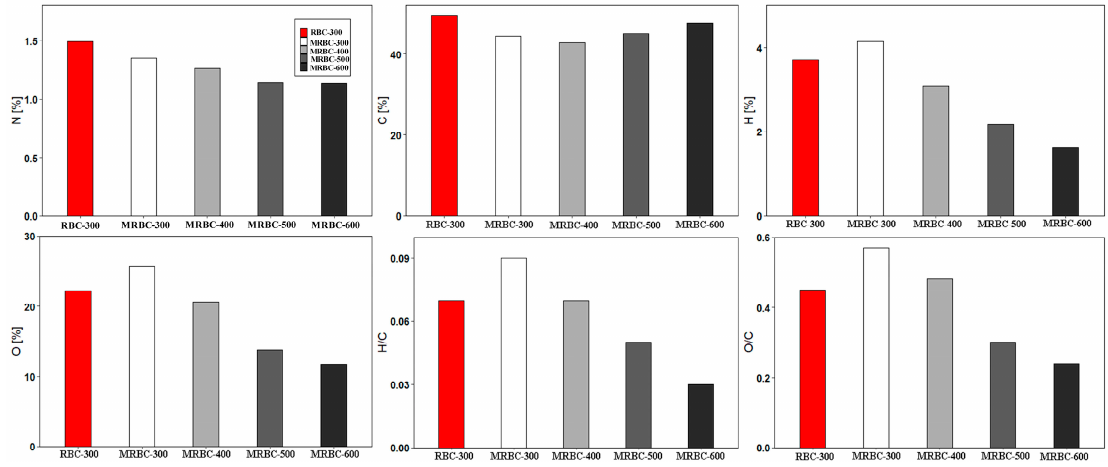
Figure 6. Elemental compositions of MRBCs and RBC.